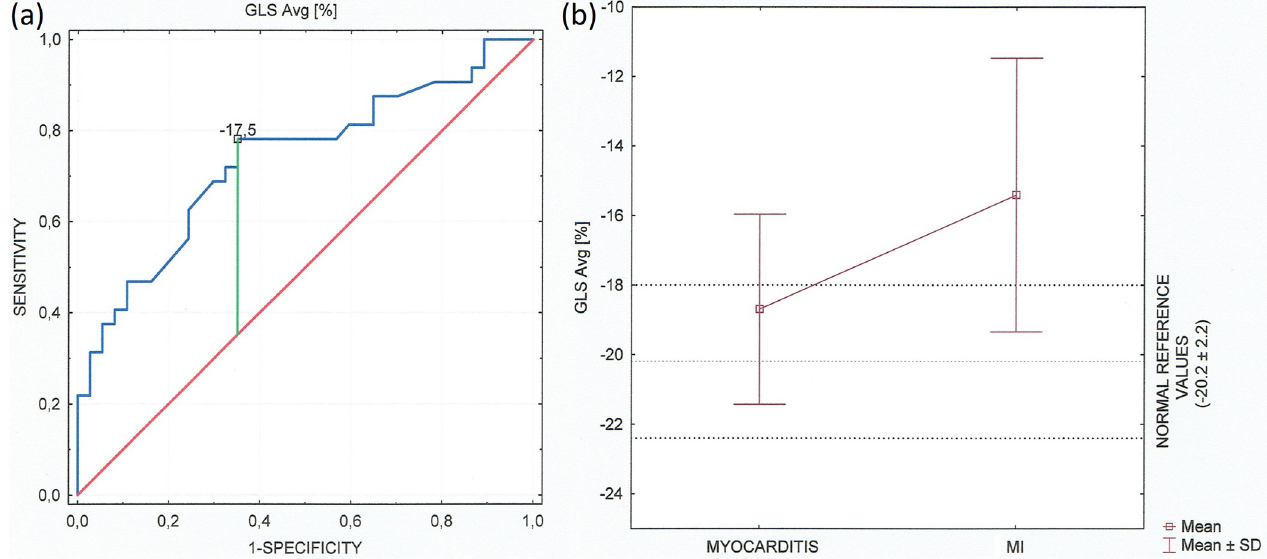
Fig 2. (a) ROC curve of the GLS average [%] for the diagnosis of clinically suspected myocarditis. The AUC was 0.737 (standard error = 0.061, 95% confidence interval 0.795–0.954). It shows that the sensitivity and specificity of the GLS is adequate in statistics (b) Global longitudinal strain [%] in the myocarditis and MI groups including normal reference of strain. Data are shown as Tukey boxplot, (p =